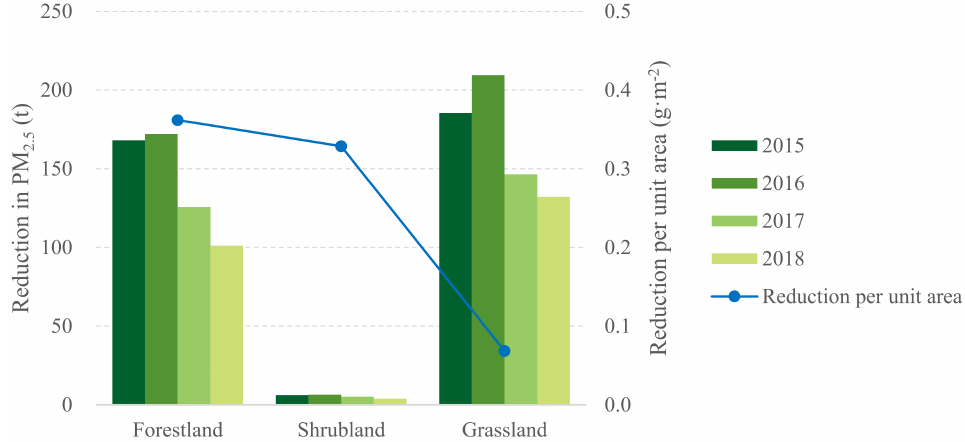
Figure 17. PM 2.5 removal each month at the built-up area scale from 2015 to 2018.